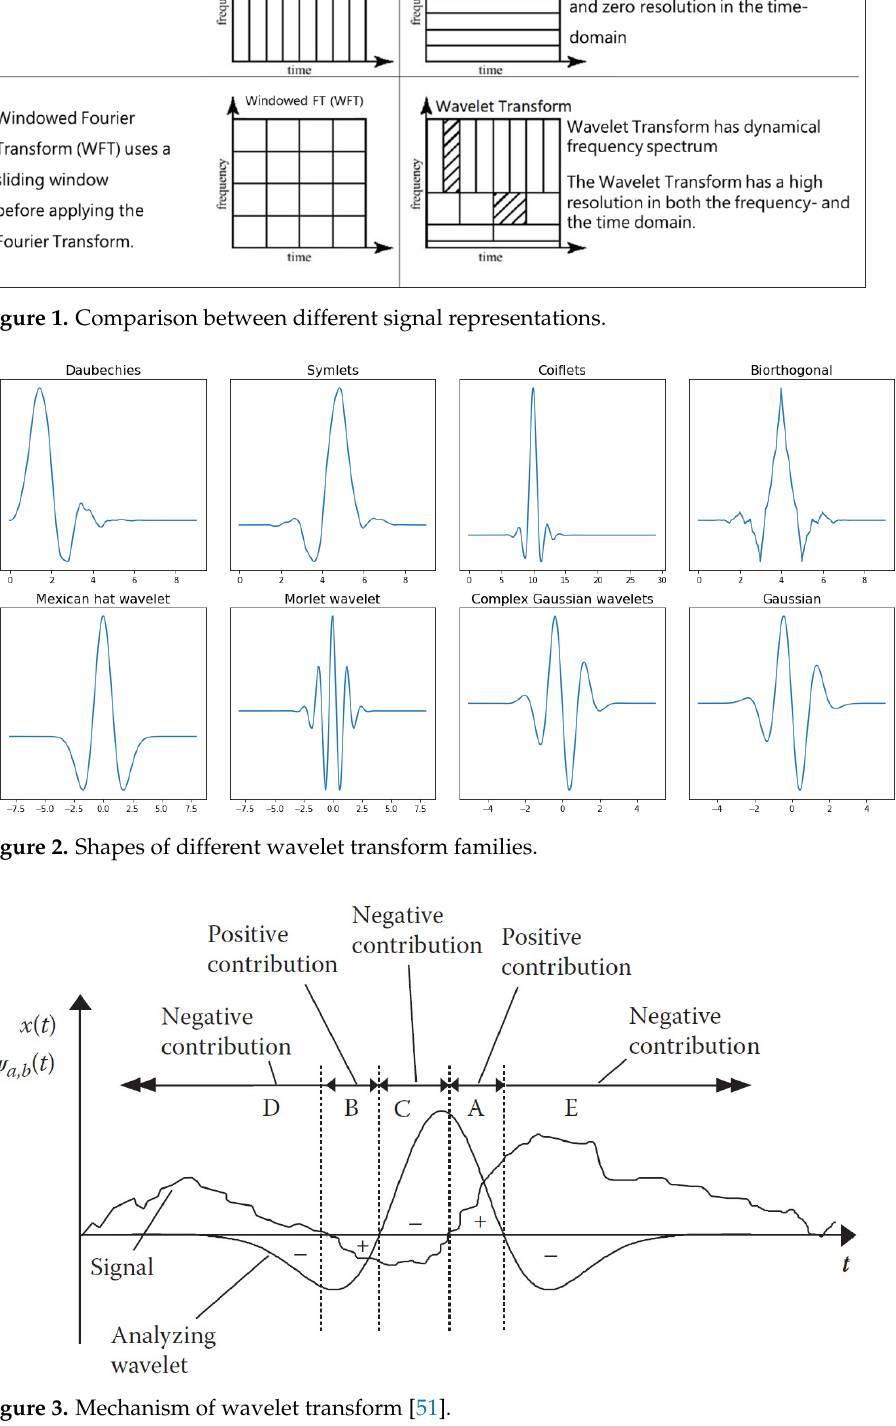
Figure 3. Mechanism of wavelet transform